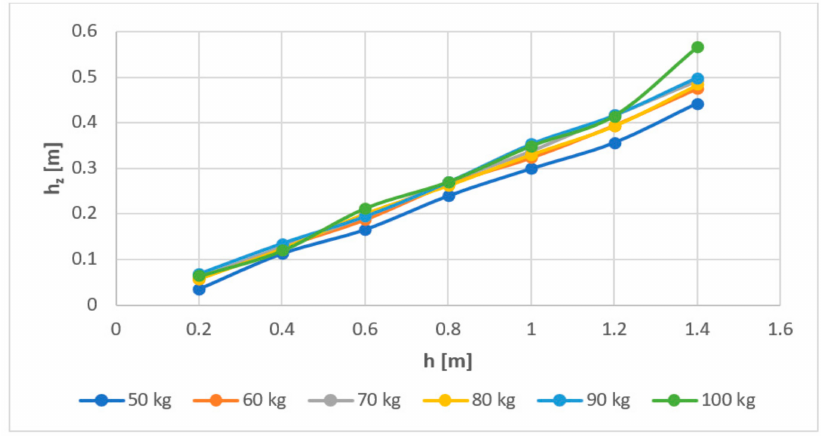
Figure 10. The correlation between the bounce height h z and the impact height h for the spherical impactor. The unconsumed portions of the total potential energy, i.e., residual positional en- ergy E Pr , were graphically presented as a function of the hammer mass for the impactor types used (Figure 11). The graph indicates that with an increasing mass, the residual energy increases too; this corresponds to increases in the bounce height. In the case of the spherical impactor, the values of the residual energy were higher because the impact work, i.e., the energy absorbed by the belt and idler support system, was lower than that with the pyramidal impactor. This was reflected in the damage to the conveyor belt components.